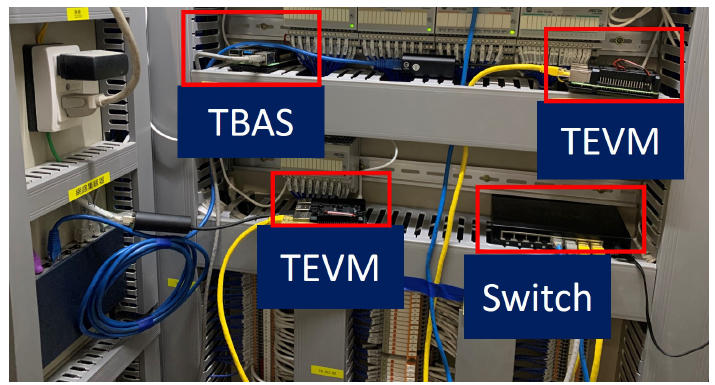
Figure 5. The setup in real energy management